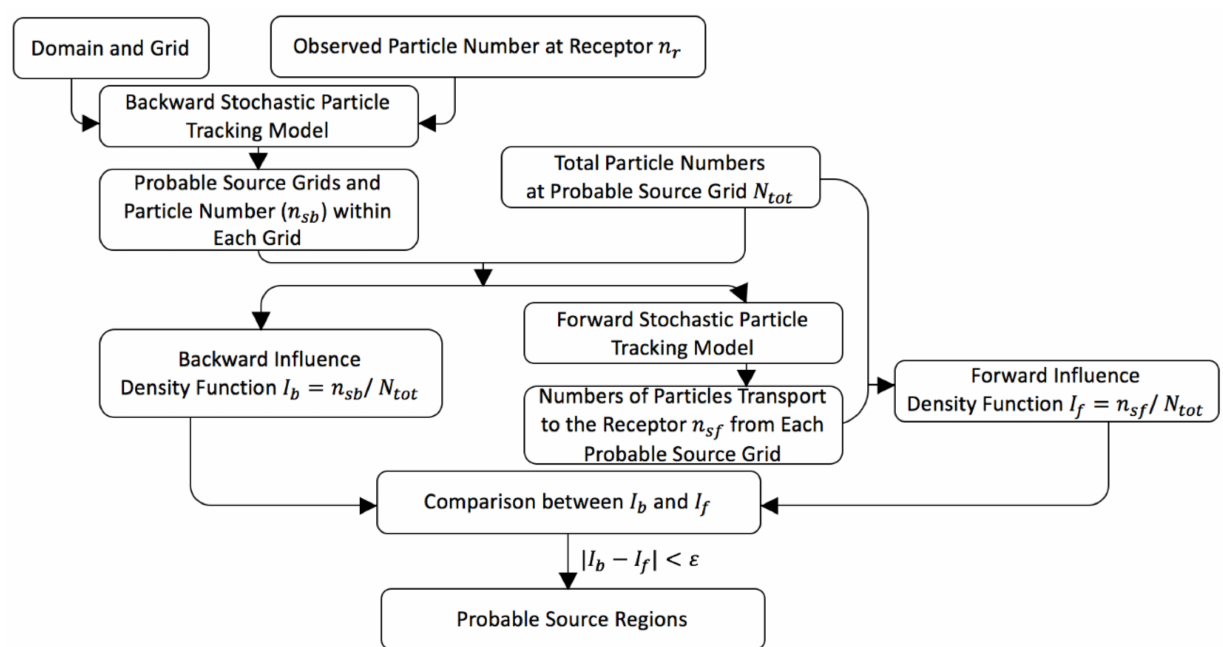
Figure 8. Simulation process of backward–forward stochastic particle tracking model.